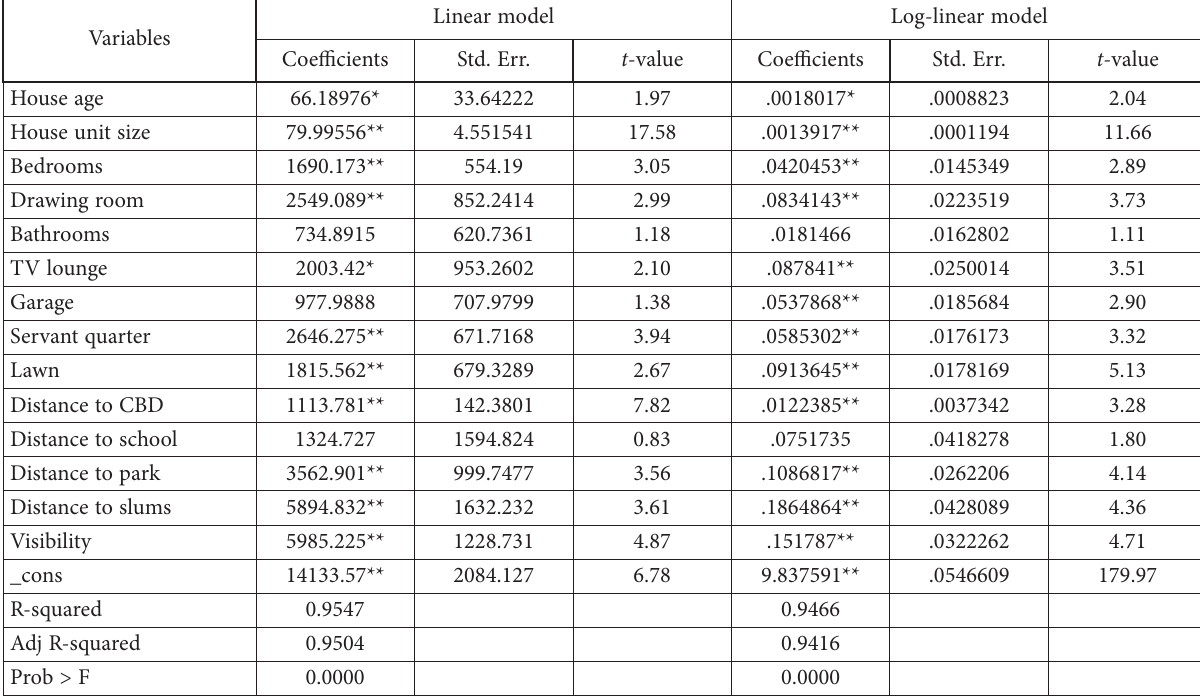
Table 4. Presenting estimates of a linear and log-linear model with data from existing slums